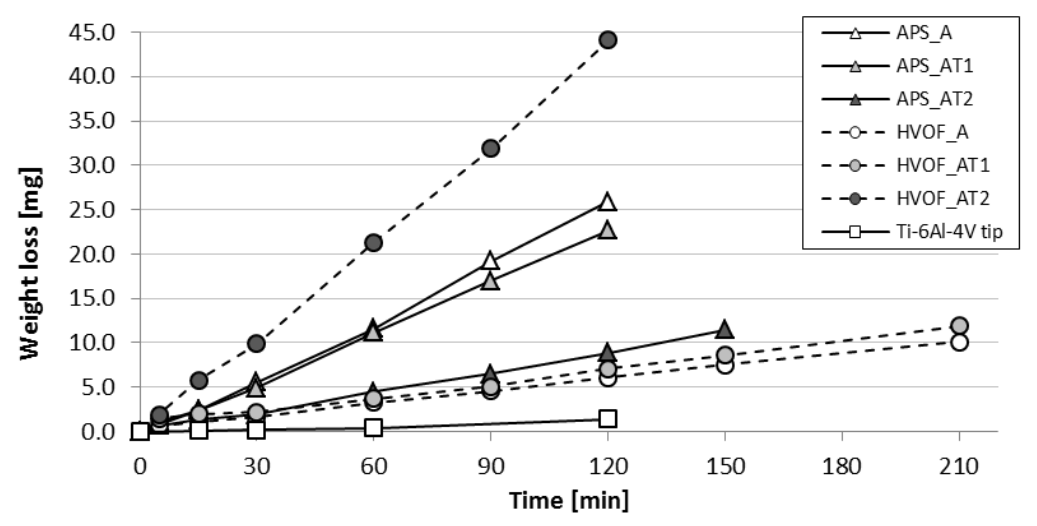
Figure 8. Weight losses of APS and HVOF coatings and Ti-6Al-4V tip material versus time in the cavitation erosion